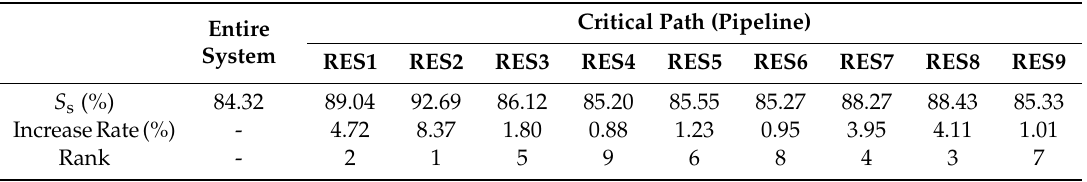
Table 3. System Serviceability Results by